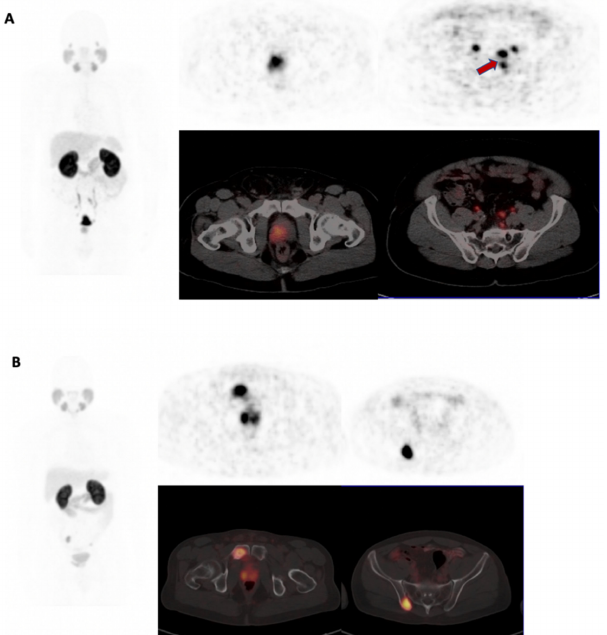
Figure 3. Comparison of whole-body (WB) PSMA-TV in WSA ( A ) and BSA ( B ) for two patients with GG 2 disease. Left: maximum intensity projection image; middle column: PET and fused PET/CT of prostate; right column: PET and fused PET/CT metastases. ( A ) 58 year-old WSA with PSA 59 ug/L, with pelvic nodal metastases (red arrow). Bilateral ureteric tracer excretion seen, WBPSMA-TV-45. ( B ) 57-year-old BSA with PSA of 30 ug/L demonstrating pelvic skeletal metastases, WBPSMA-TV–58.